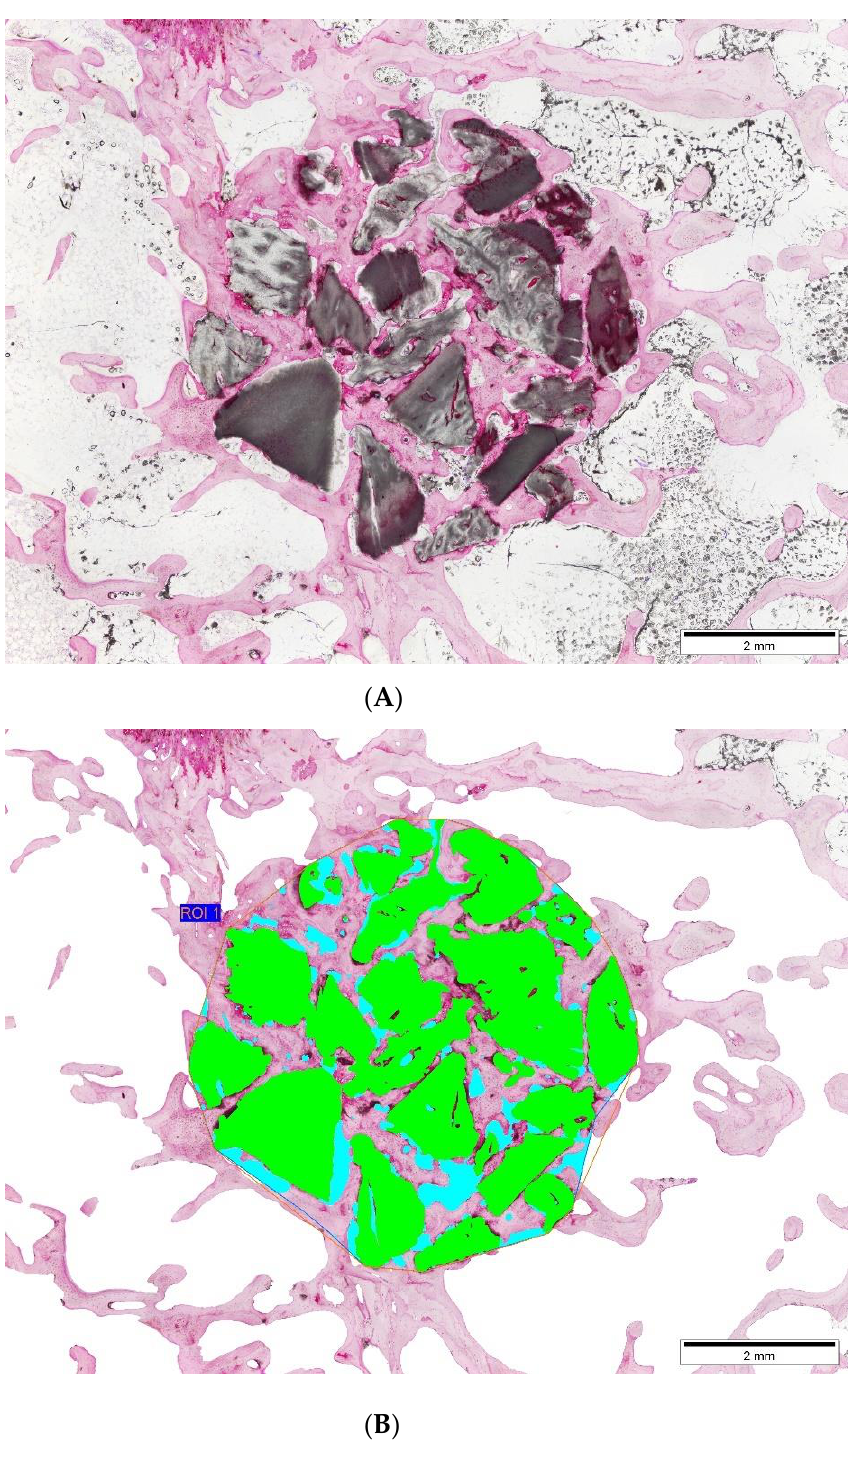
Figure 3. Shark tooth-derived bone graft samples before ( A ) and after ( B ) digital coloring and analysis: bone graft (green), bone tissue (pink) and connective tissue (blue). Magnification 4×.